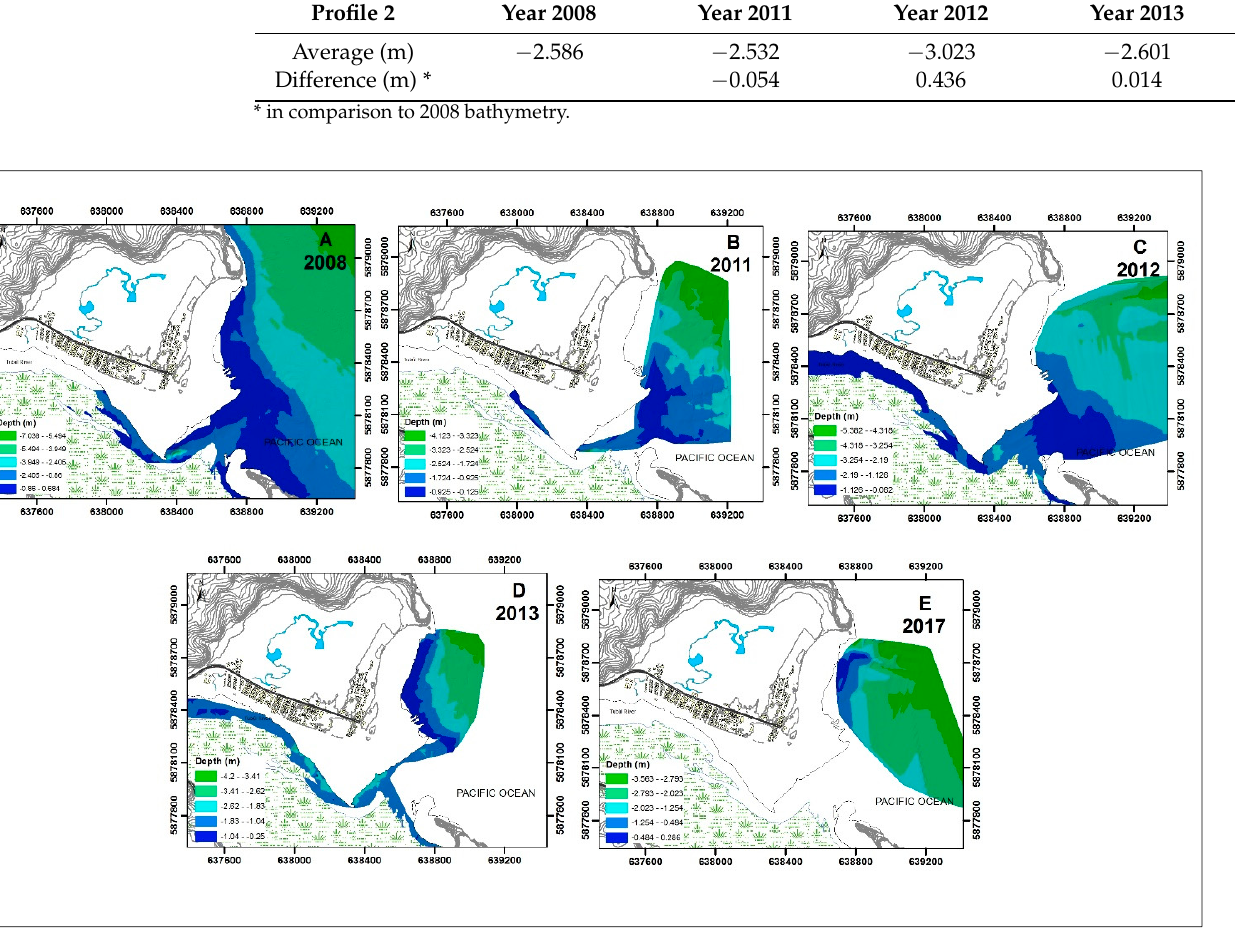
Figure 6. Bathymetry of Tubul Bay, in pre- and postearthquake conditions. The figure presents four bathymetric surveys carried out between 2008 and 2017 ( A – E ). In the last three ( C , D , E ), the effect of the earthquake is registered as generating shallower depths in the adjacent oceanic zone.